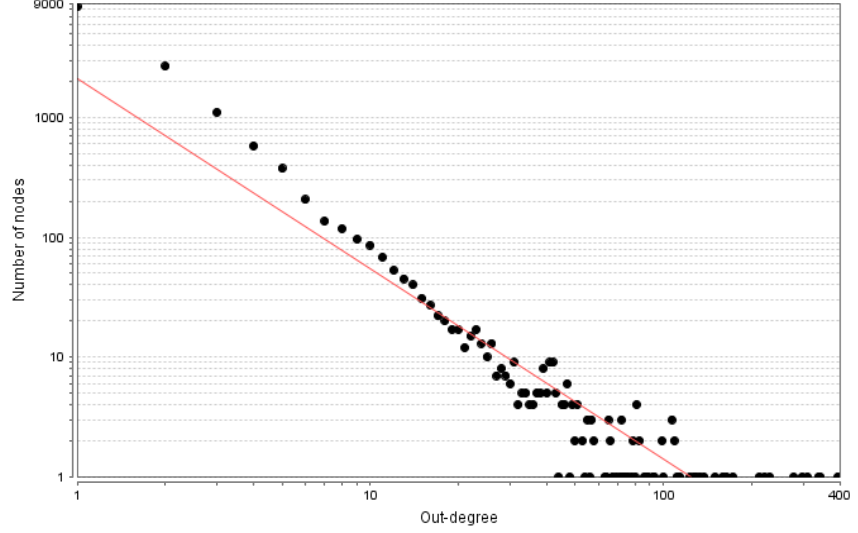
Fig. 3. Out-degree Distribution of the Nodes on a Log-log Scale The function of out-degree distribution (Fig. 3) is quite similar to that of the previous one. Hence, there are firms, institutions, or universities in the network that do the opposite of the knowledge “black holes”. The tail of the distribution, namely, the nodes with the greatest out-degrees, transmit knowledge to the network and continuously lose their researchers and knowledge base. The greatest giver in this case had to let its patenting inventors go to 394 different organizations. How could a firm survive such great losses? Maybe these great knowledge-providers went bankrupt or downsized.